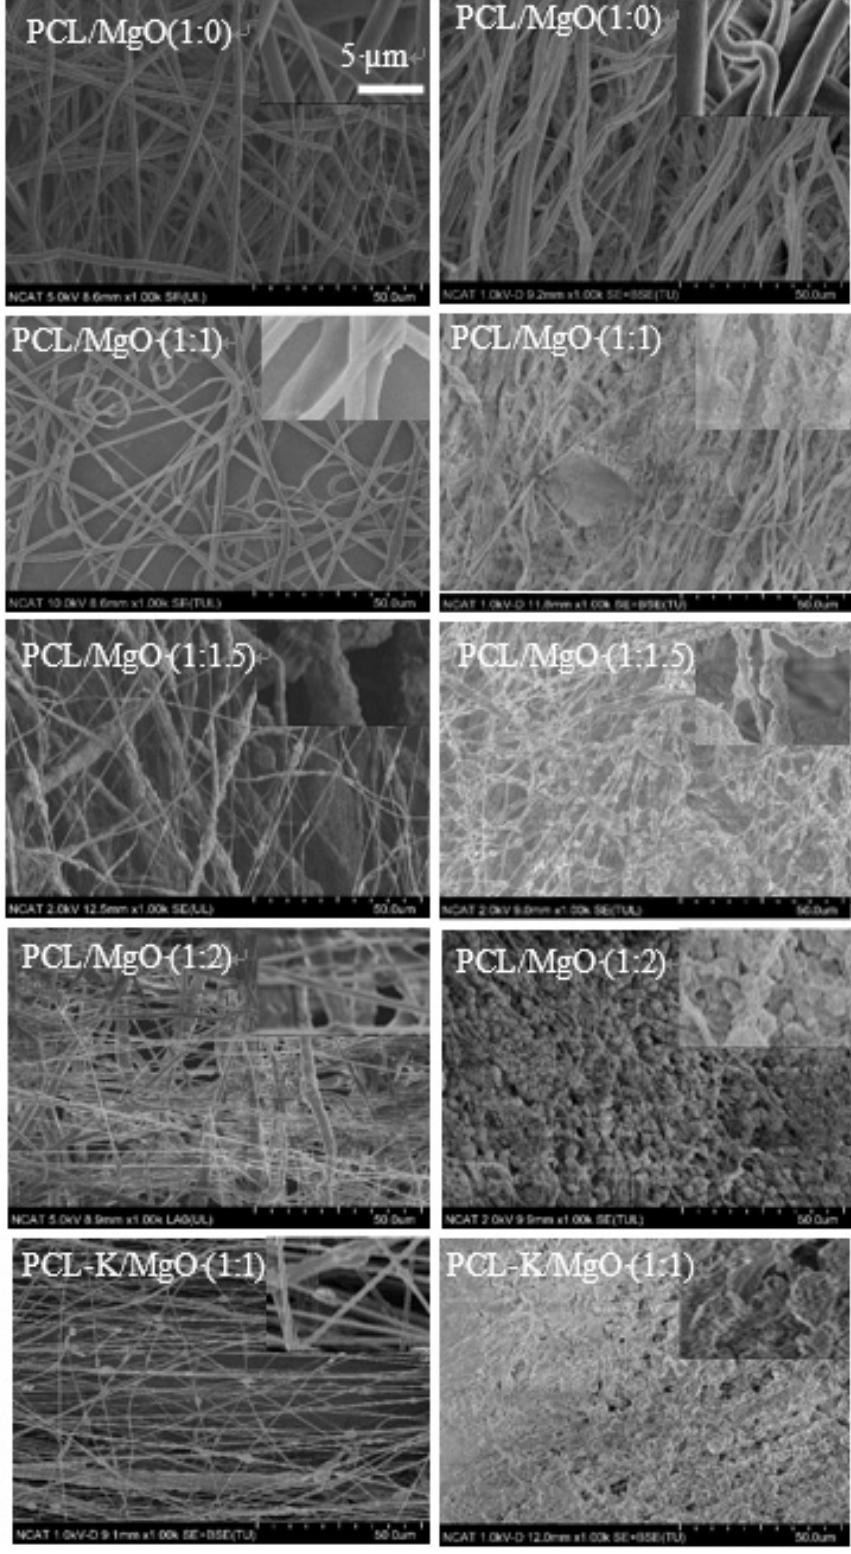
Figure 8. SEM images of in vitro degradation of nanofibers. Left images are from Day 0; right images are from Day 7. The scale bar is 50